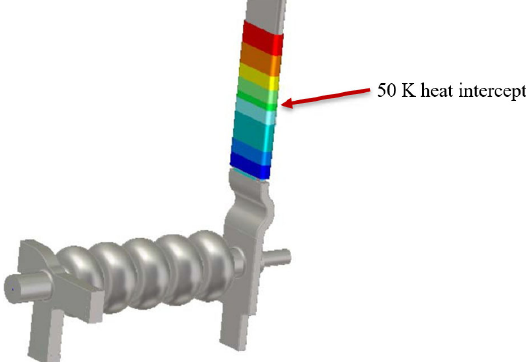
FIG. 20. The rf model for resembling a C75 cavity in a CM configuration including the losses in the copper-plated stainless steel. The copper plating covers the region above the cold window to the warm window (not included in the model). The electrical conductivity of the copper plating with RRR ¼ 30 ranges from 1 . 94 × 10 9 S = m (blue) to 5 . 7 × 10 7 S = m